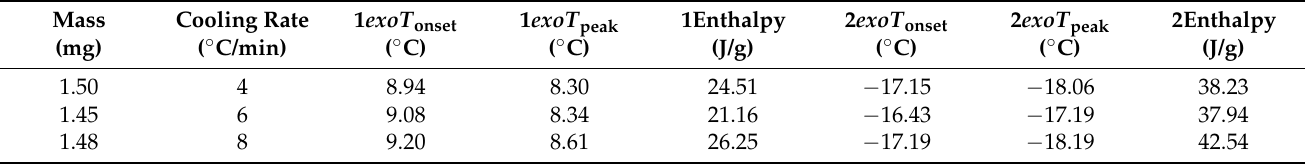
Figure 4. R. mucilaginosa lipids analyzed by differential scanning calorimetry (DSC) with heating rates of 4, 6, and 8 ◦ C/min, with the temperature ranging from 30 to 300 ◦ C. Table 3. DSC analysis results for R. mucilaginosa lipids with heating rates of 4, 6 and 8 ◦ C/min, with operating temperature ranging from 30 to 70 ◦ C, and then cooling to − 60 ◦